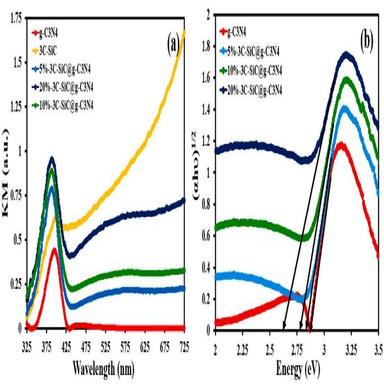
Absorption spectra deduced from UV-DRS spectra (a), Tauc plot to determine band gap energies (b) of pure g-C3N4 and 3C–SiC@g-C3N4 nanocomposites.